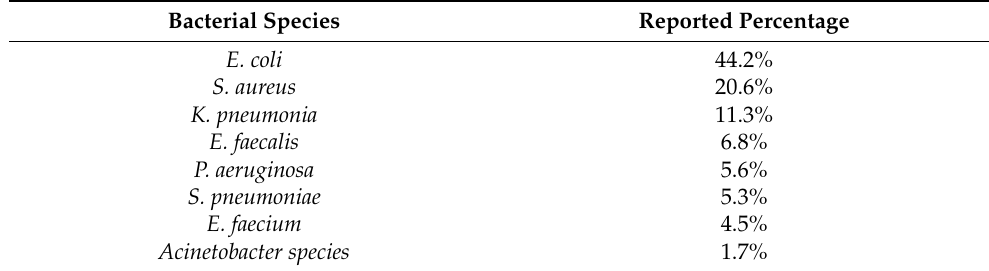
Table 1. Percentage of reported bacterial species according to the EARS-Net report in 2019 [18]. Bacterial